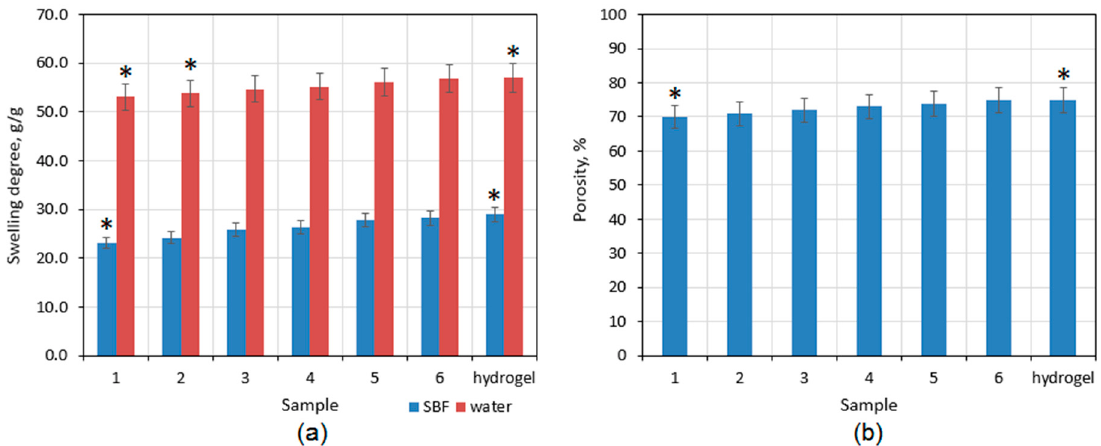
Figure 8. ( a ) Swelling degree of the developed samples: (1) CS-ZnO-6; (2) CS-ZnO-5; (3) CS-ZnO-4; (4) CS-ZnO-3; (5) CS-ZnO-2, and (6) CS-ZnO-1. ( b ) Porosity of the developed samples: (1) CS-ZnO-6; (2) CS-ZnO-5; (3) CS-ZnO-4; (4) CS-ZnO-3; (5) CS-ZnO-2, and (6) CS-ZnO-1. (* p < 0.05).